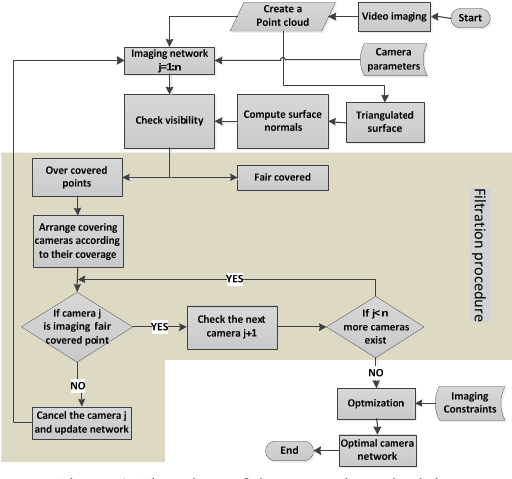
Figure 4. Flowchart of the research